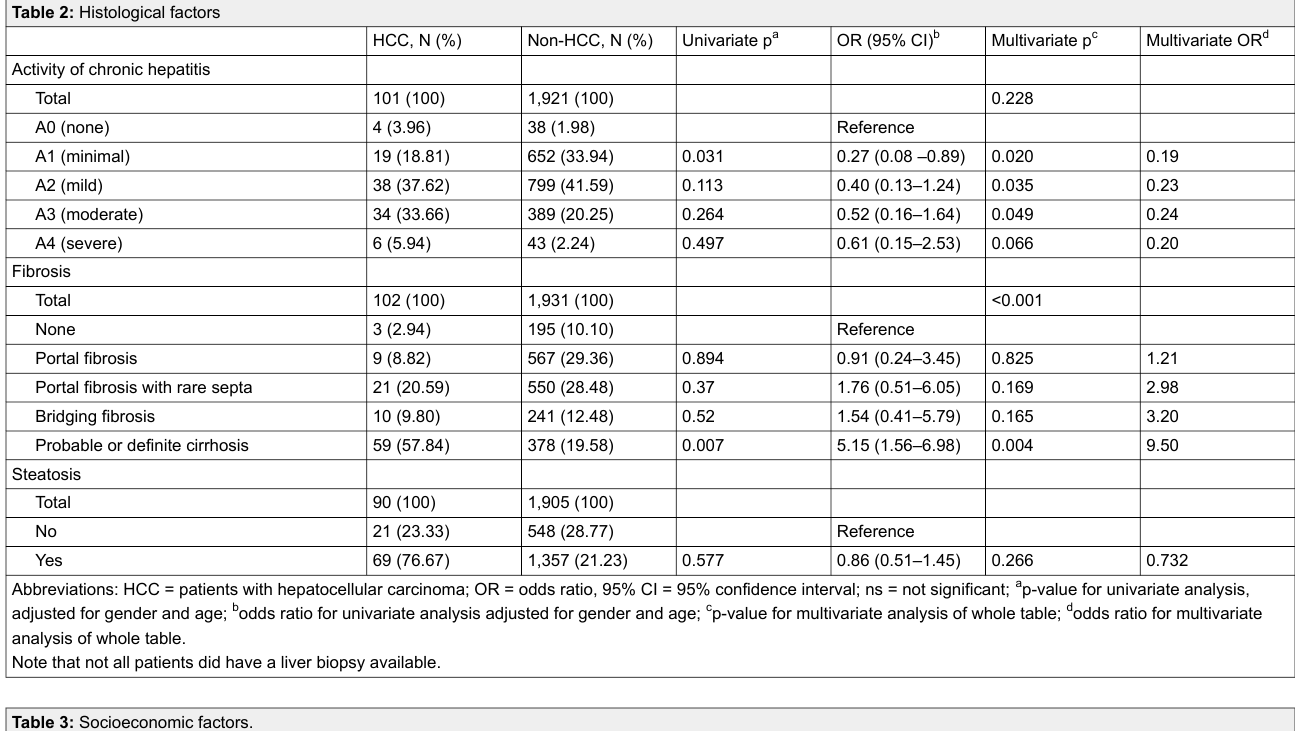
Table 3: Socioeconomic factors.